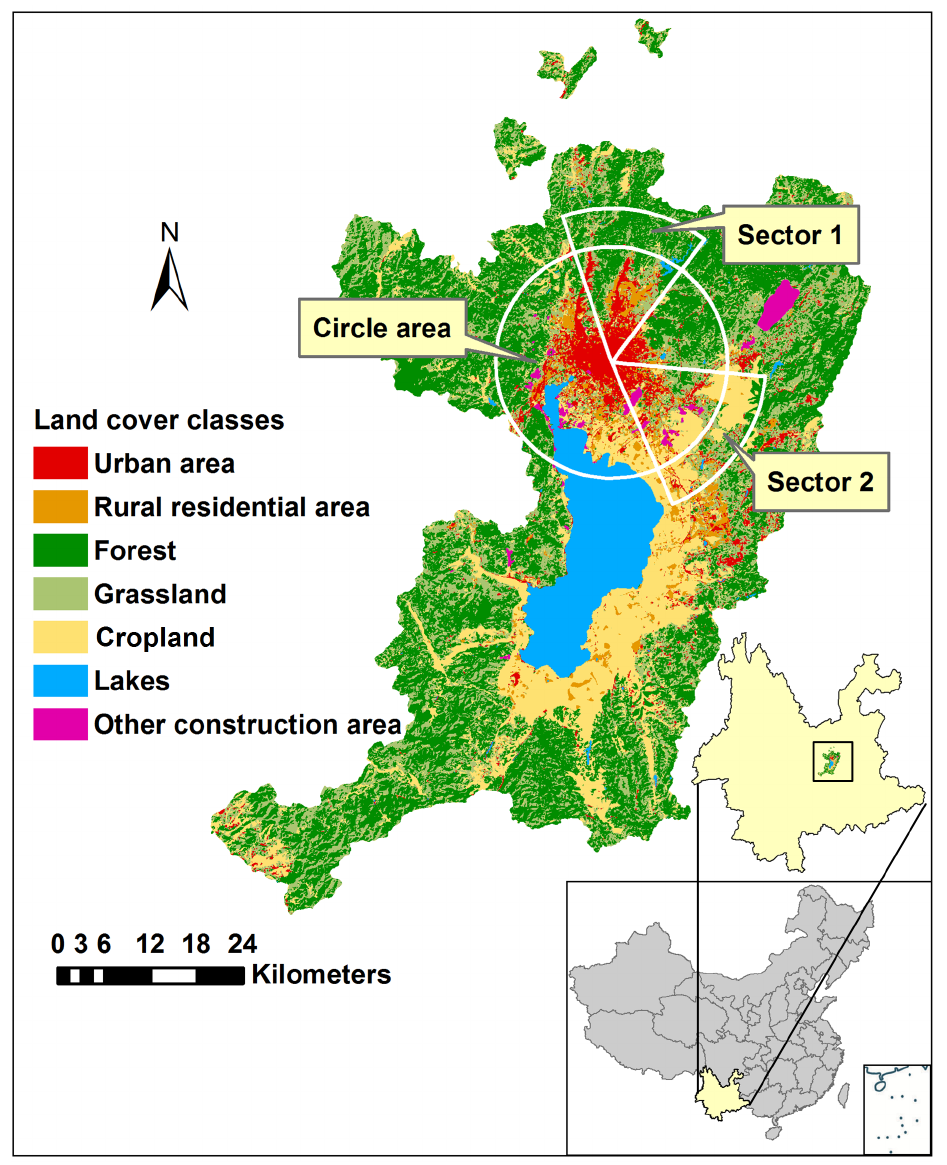
Figure 2: Land cover map of the Kunming urban-rural area for 2010. The seven primary classes have been aggregated from the classes of the National Land Classification (applicable in transitional period) released by the Ministry of Land and Resources of China in 2002 . The circle area with a radius of 15 kilometers and sectors 1 and 2 with radiuses of 20 kilometers are the areas for gradient